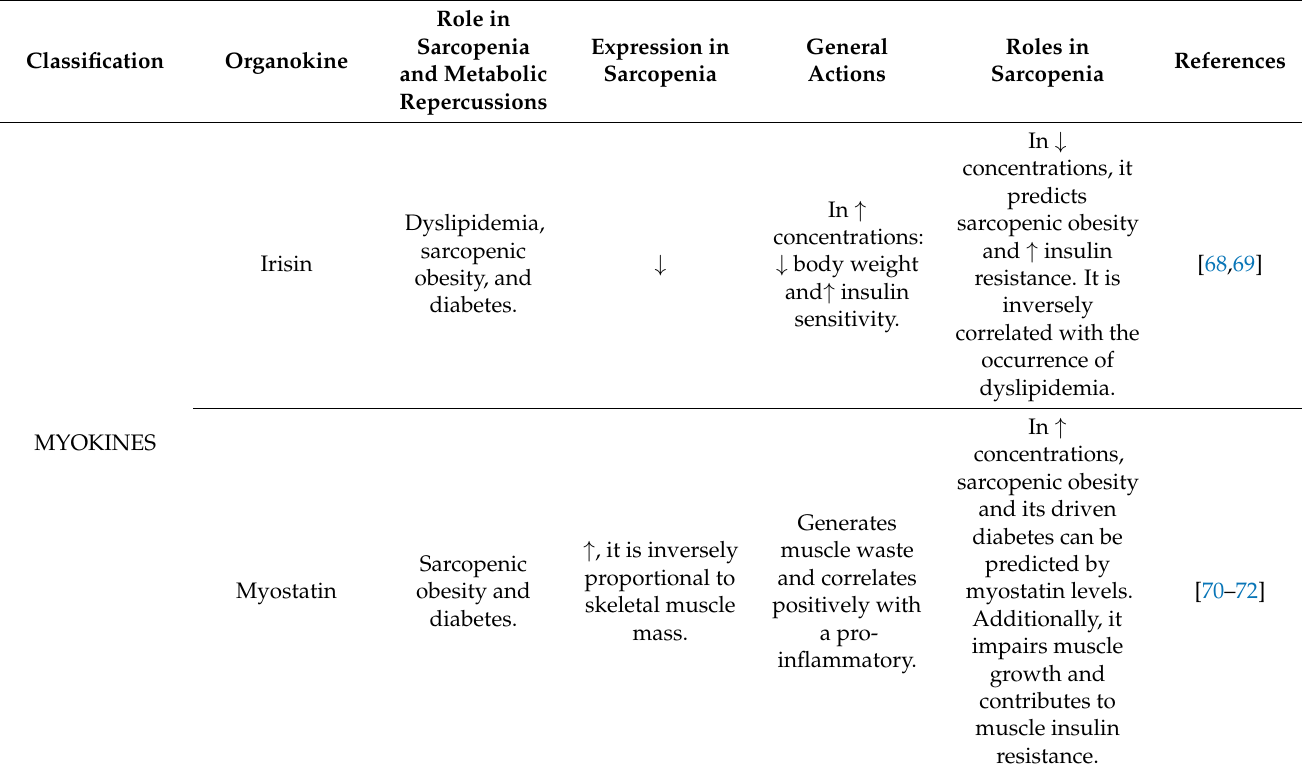
Table 1. Main characteristics of the organokines involved in the pathophysiology of sarcopenia, diabetes, sarcopenic obesity, and